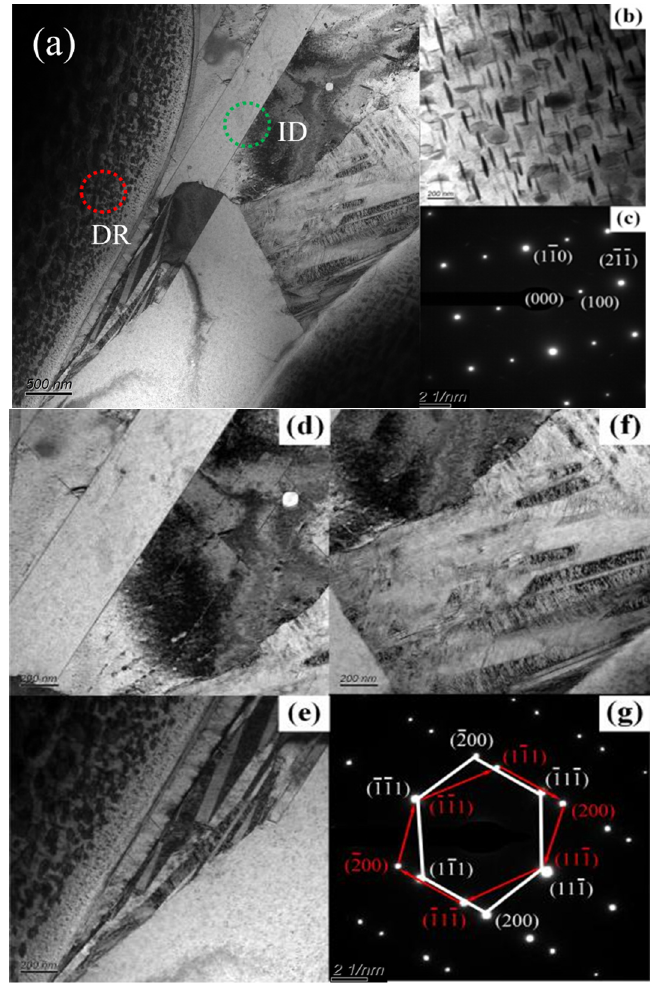
Figure 6. TEM images and the corresponding SAED patterns of the FeCoCrAlCu HEA coating: ( a ) bright-field image, ( b ) bright-field image of the partial BCC phase, ( c ) SAED pattern of the BCC, ( d ) bright-field image of the partial FCC phase, ( e ) bright-field image of the nanotwinned FCC phase, ( f ) bright-field image of the FCC phase boundary, and ( g ) SAED pattern of the FCC.